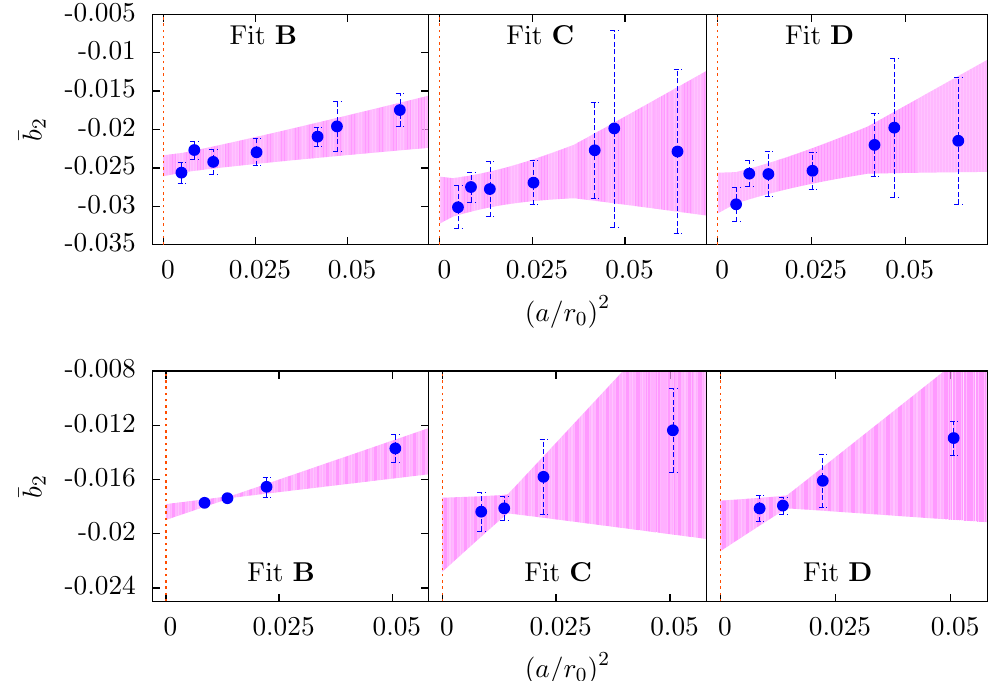
Figure 6 . Results for the linear continuum extrapolation, (cid:12)t (2), for the results for (cid:22) b 2 obtained from (cid:12)ts B , C and D (from left to right) for SU(2) (top) and SU(3) (bottom) gauge